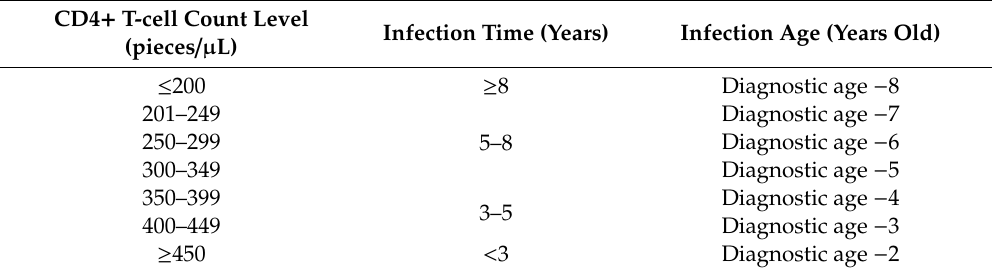
Table 1. CD4 + T-cell count level and the estimated human immunodeficiency virus (HIV) infection time and age of